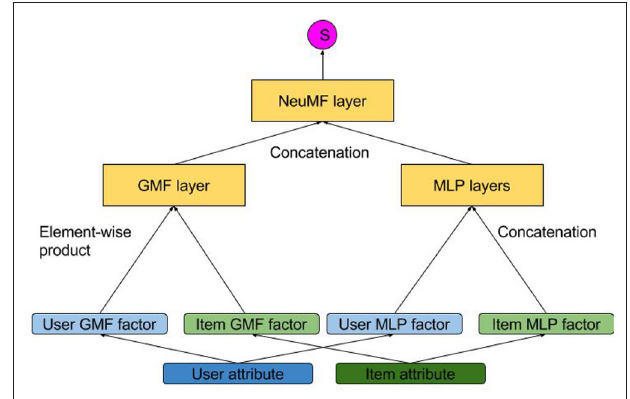
TABLE 9 | Percentage of new users/items (users/items in testing data but not in training